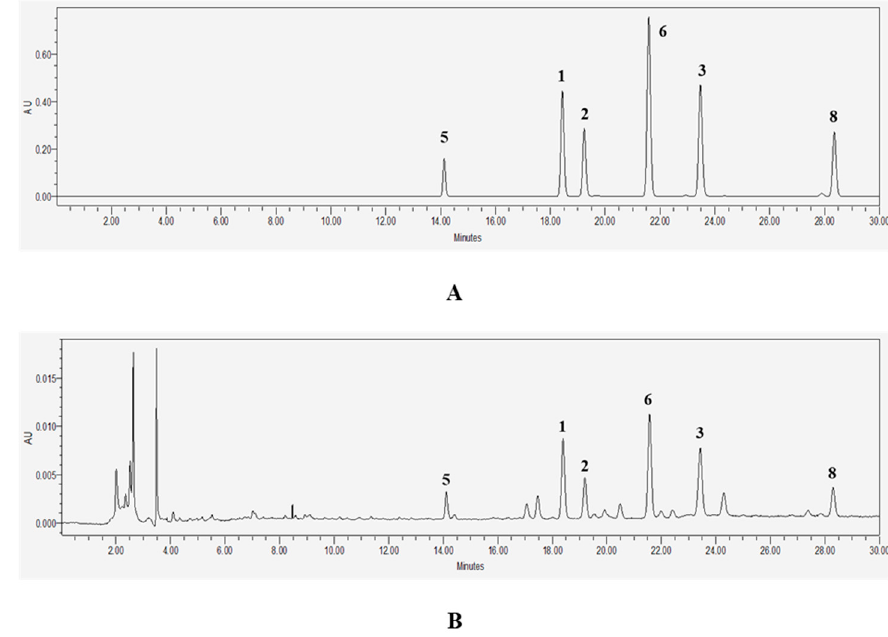
Figure 2. Chromatograms of standards mixture ( A ) and M. officinalis crude MeOH extract ( B ).